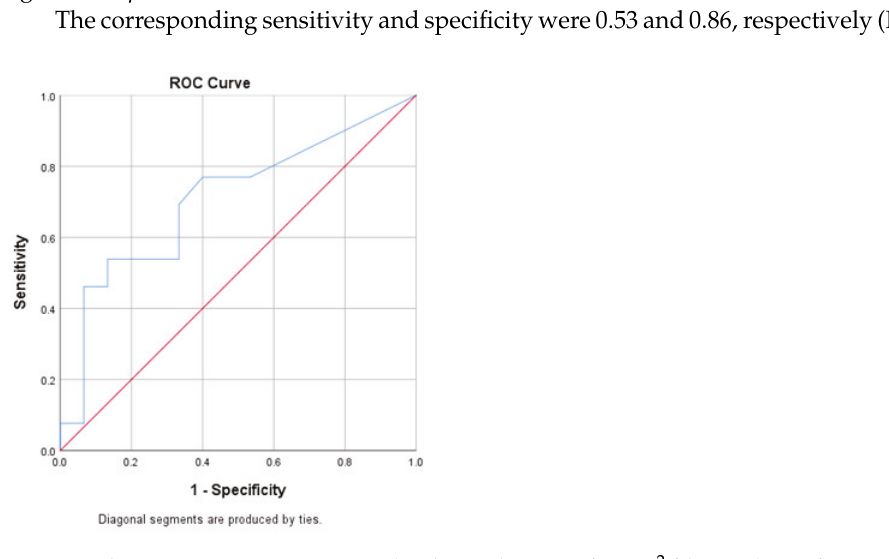
Table 3. The logistic regression coefficients for the dependent variable for day 3 CrCl < 90/mL/1.73 m 2 .